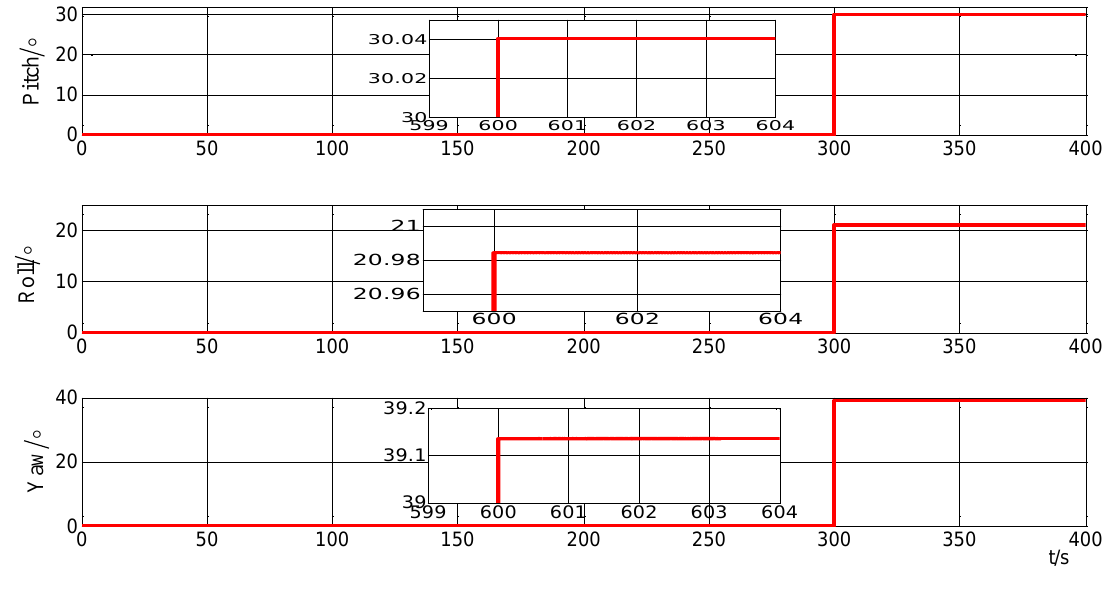
Figure 17. Curves of alignment for the turntable test in static.